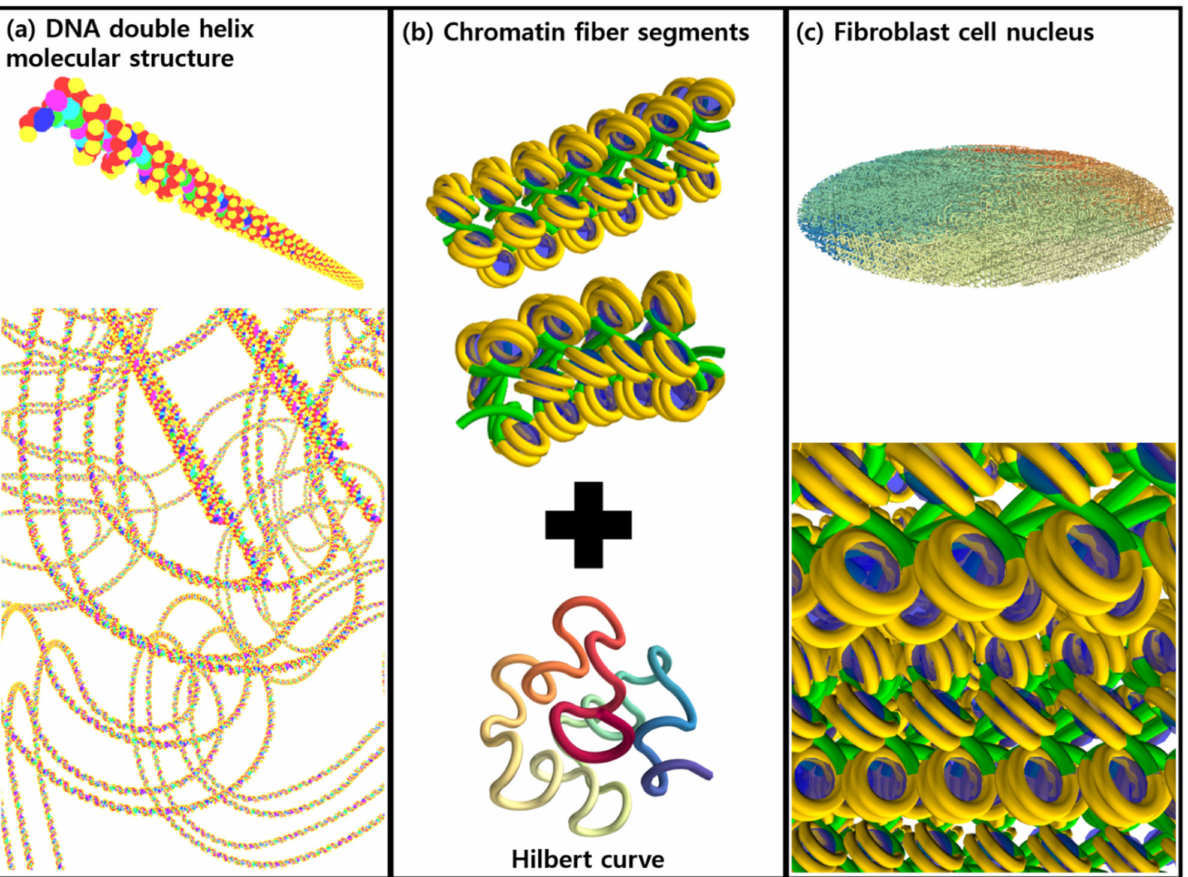
Figure 1. ( a ) Schematic illustration of the molecular structure of the DNA double helix. The spheres represent adenine (C 5 H 5 N 5 , blue), thymine (C 5 H 6 N 2 O 2 , magenta), guanine (C 5 H 5 N 5 O, green), cytosine (C 4 H 5 N 3 O, cyan), sugar (C 5 H 10 O 4 , deoxyribose, red), and phosphate (H 3 PO 4 , yellow), respectively. ( b ) Simplified chromatin fiber segments (straight and turned) and a unit of Hilbert curve. ( c ) The modeled fibroblast cell